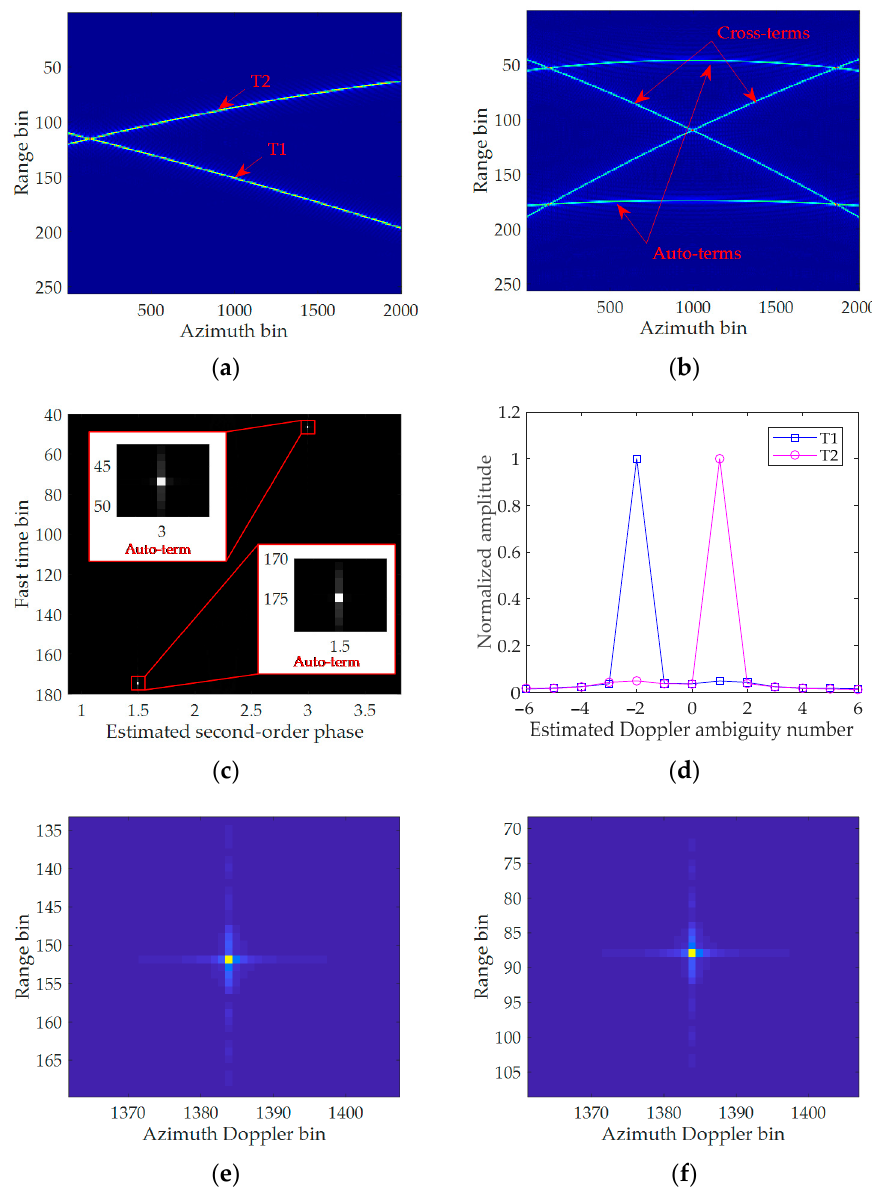
Figure 3. Results of simulation example A: ( a ) Result of range compression. ( b ) Result of parameter separation operation in Equation (10). ( c ) Modified second-order keystone transform (MSOKT) result. ( d ) Estimated result of Doppler ambiguity number. ( e ) Final refocused result of T1. ( f ) Final refocused result of